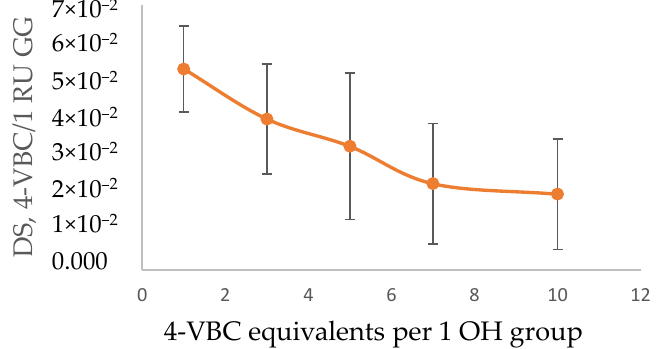
Figure 2. Degree of substitution (DS) of the GG — attached 4-VBC groups per one repeating unit (RU) in GG.